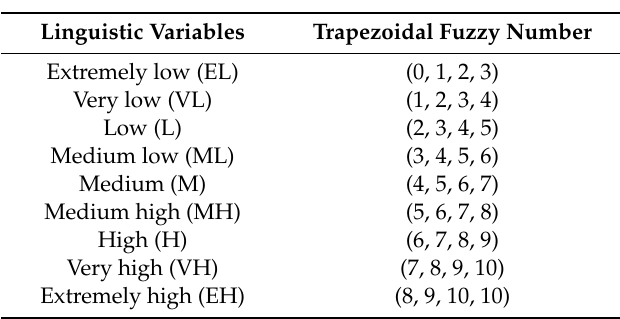
Table 1. Linguistic variables.